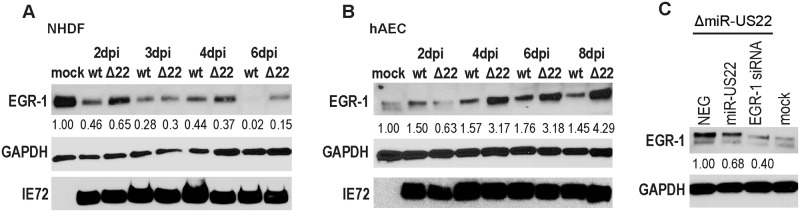
miR-US22 targets endogenous EGR-1 during HCMV infection.(A, B) TB40E miR-US22 mutant virus fails to down-regulate endogenous EGR-1 levels during infection. NHDF (A) or AEC (B) were infected with TB40E WT or ΔmiR-US22 virus (MOI = 3). Cell lysates were harvested at the indicated timepoints for IB analysis (C) miR-US22 mimic downregulates EGR-1 in cells infected with the miR-US22 mutant virus. AECs were transfected with the indicated siRNA or miRNA mimics. After 24 hours, the cells were infected with TB40E ΔmiR-US22, and harvested 4 days later for IB analysis. Protein levels were normalized to GAPDH, and relative levels are displayed.